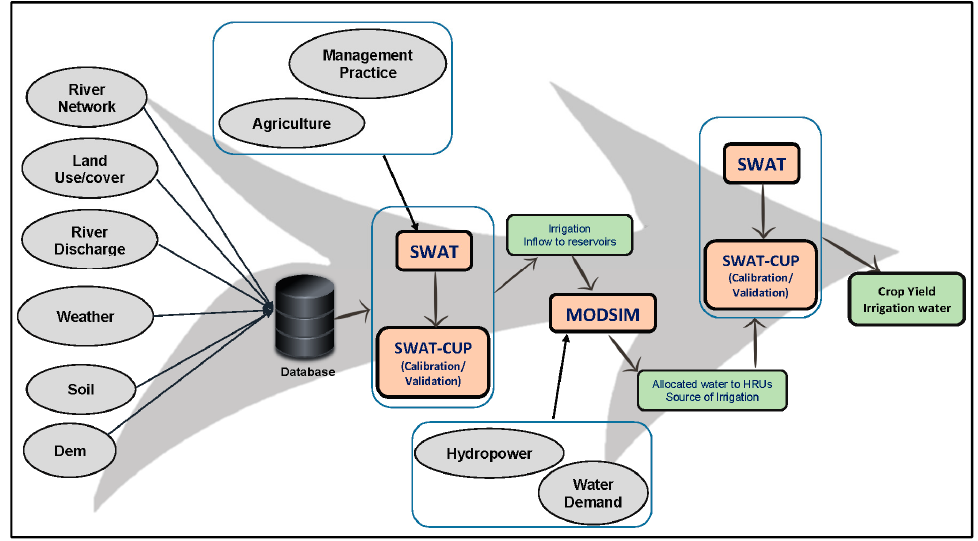
Figure 4. Overview of the input–output and information exchange in the SWAT–MODSIM (SM) model.